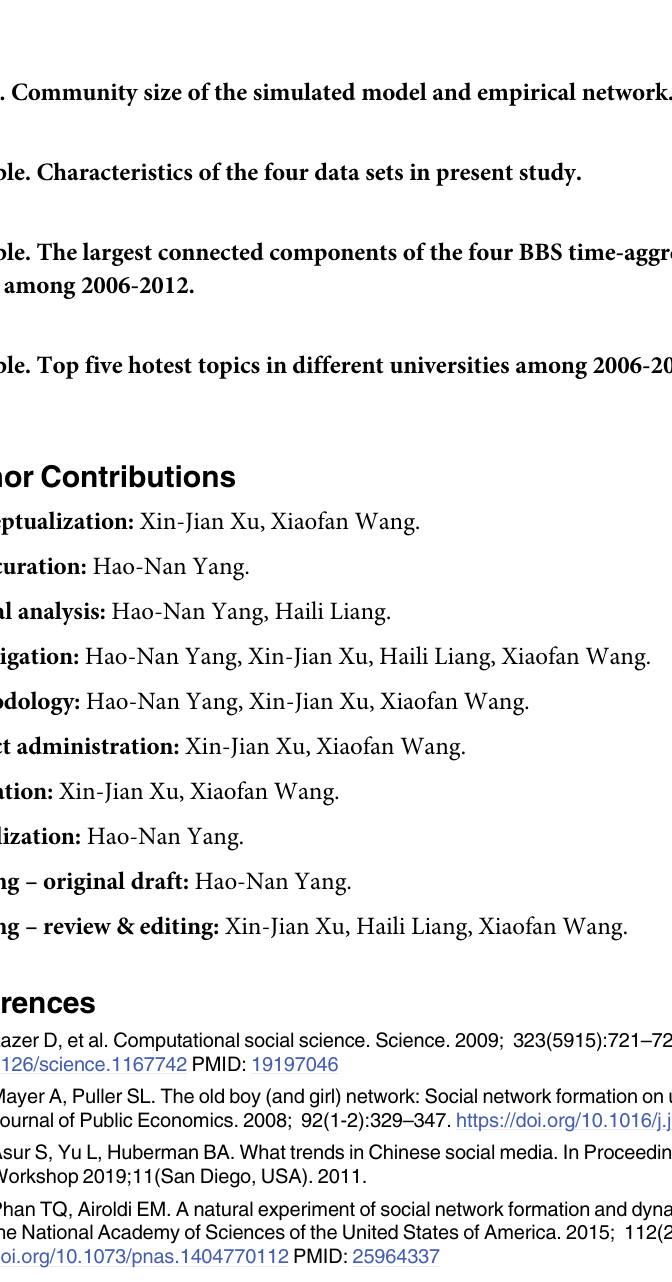
S1 Fig. The hierarchical structure of a BBS (a) and a typical reply article (b). (PDF) S2 Fig. Degree distributions of reply networks with fitted power laws. (PDF) S3 Fig. Top increasing and decreasing topics in each university. (PDF) S4 Fig. Top and bottom degree distributions of empirical bipartite network in each univer- sity. S5 Fig. Community size of the simulated model and empirical network. S1 Table. Characteristics of the four data sets in present study. S2 Table. The largest connected components of the four BBS time-aggregated reply net- works among 2006-2012. S3 Table. Top five hotest topics in different universities among